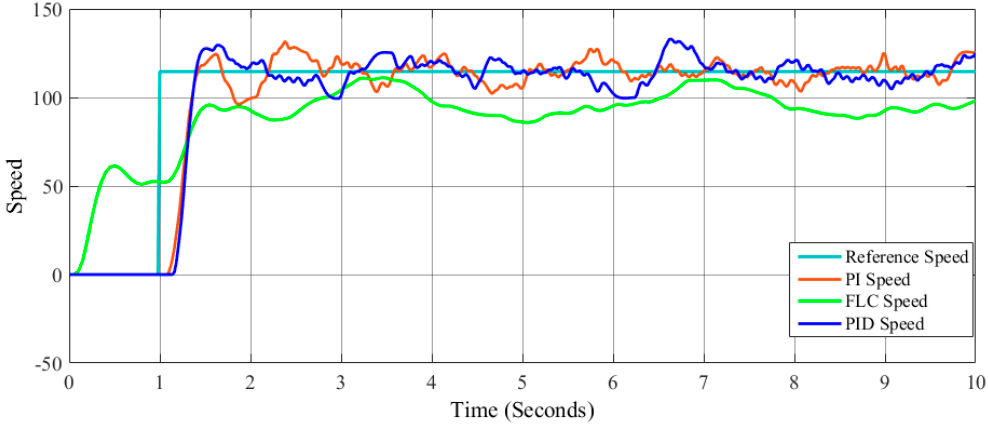
Figure 19. Graphic representation of the best result obtained.